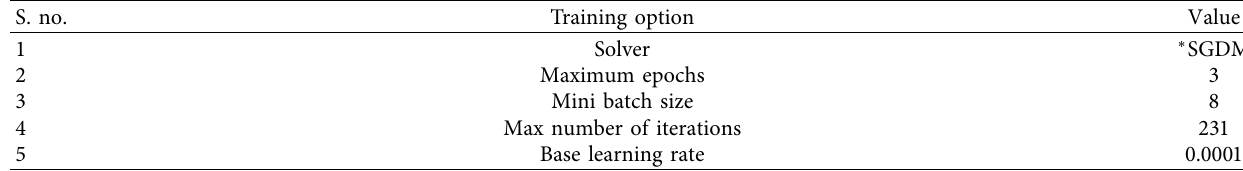
Table 3: T raining options employed for the pretrained